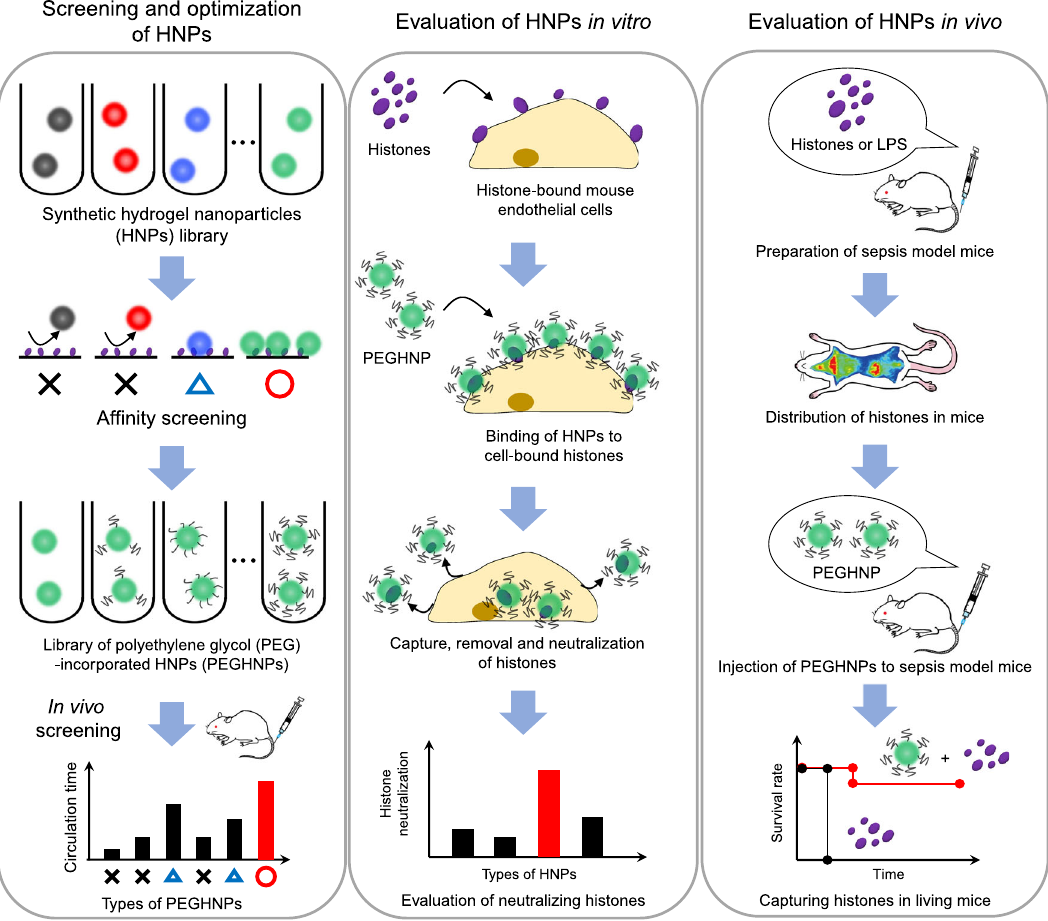
Fig. 1 Work fl ow of this study. First, we develop HNPs with PEG modi fi cation to optimize their histone af fi nity, capacity, low-aggregation, and blood circulation time altogether to achieve highly effective sepsis therapy. Next, we evaluate PEGHNPs in vitro. Finally, we evaluate the ef fi cacy of PEGHNPs using living mice in